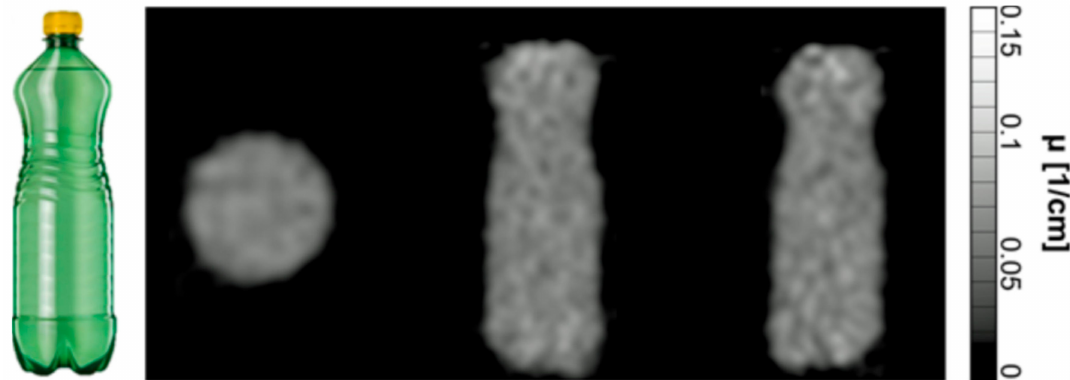
Figure 10. PET attenuation map. Left : Water bottle (1 L) used for the first PET AC calculations. Right : Reconstructed attenuation maps in all three directions using acquired data from the transmission